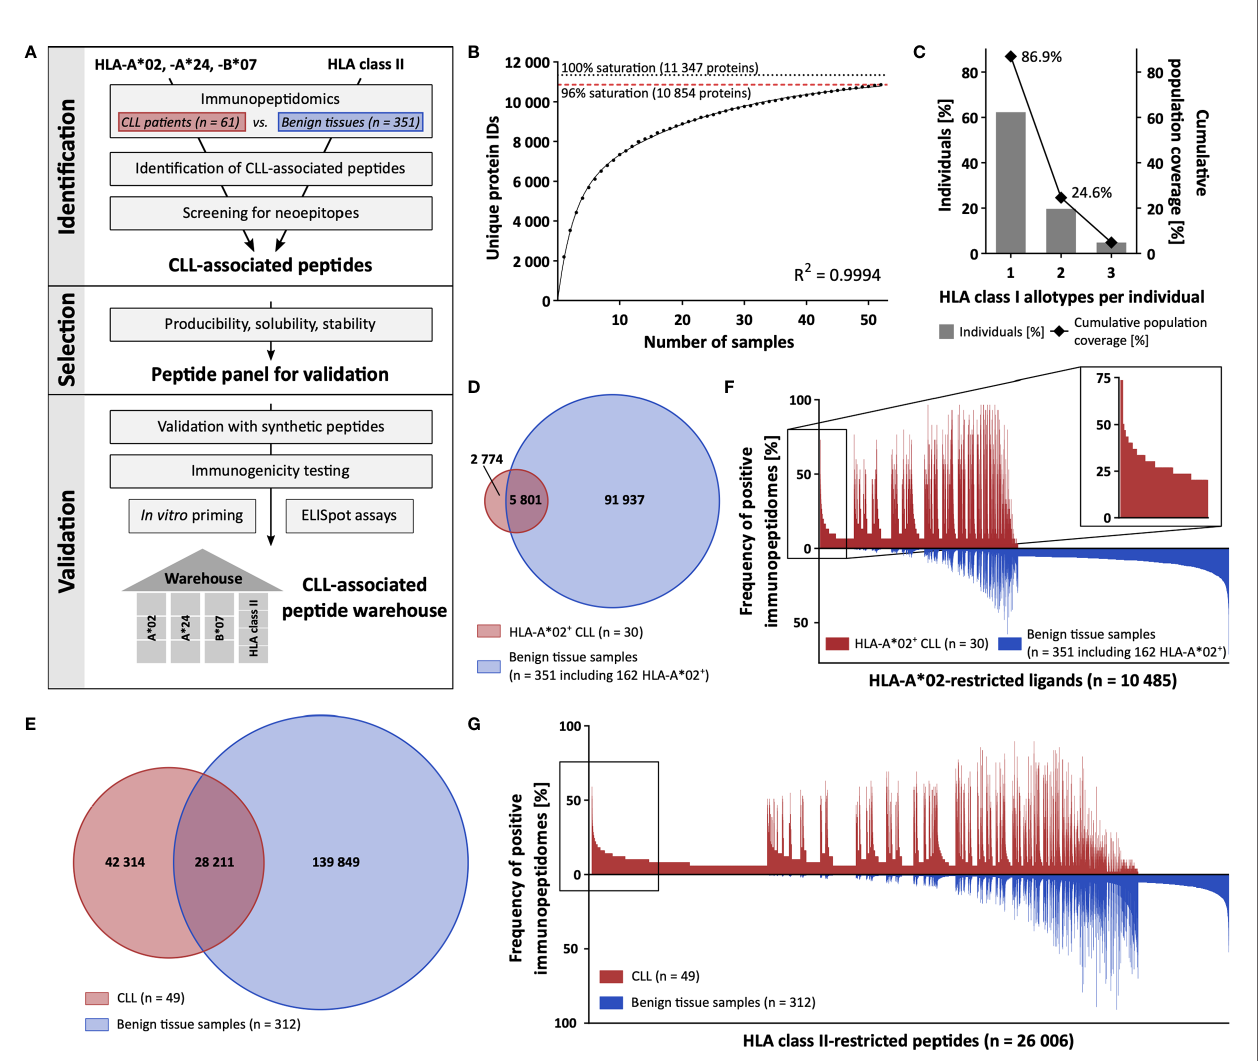
FIGURE 1 | Comparative immunopeptidome pro fi ling identi fi es CLL-associated antigens. (A) Mass spectrometry-based work fl ow for the design of a CLL-associated immunopeptidome-derived peptide warehouse. (B) Saturation analysis of source proteins of HLA class I-presented peptides. Number of unique source protein identi fi cations shown as a function of cumulative immunopeptidome analysis of CLL samples (n = 52). Exponential regression allowed for the robust calculation of the maximum attainable number of different source protein identi fi cations (dotted line). The dashed red line depicts the source proteome coverage achieved in the CLL cohort. (C) HLA-A*02, -A*24, and -B*07 allotype coverage within the CLL cohort (n = 61). The frequencies of individuals within the CLL cohort carrying up to three HLA allotypes (x-axis) are indicated as gray bars on the left y-axis. The cumulative percentage of population coverage is depicted as black dots on the right y-axis. (D, E) Overlap analysis of (D) HLA-A*02- and (E) HLA class II-restricted peptide identi fi cations of primary CLL samples (D, n = 30; E, n = 49) and benign tissue samples (D, n = 351 including 162 HLA-A*02 + ; E, n = 312). (F, G) Comparative immunopeptidome pro fi ling of (F) HLA-A*02- and (G) HLA class II-presented peptides based on the frequency of HLA-restricted presentation in immunopeptidomes of CLL and benign tissue samples. Frequencies of positive immunopeptidomes for the respective HLA-presented peptides (x-axis) are indicated on the y-axis. To allow for better readability, HLA-presented peptides identi fi ed in < 5% of the samples within the respective cohort were not depicted. The box on the left highlights the subset of CLL-associated antigens that show CLL-exclusive high-frequent presentation. IDs, identi fi